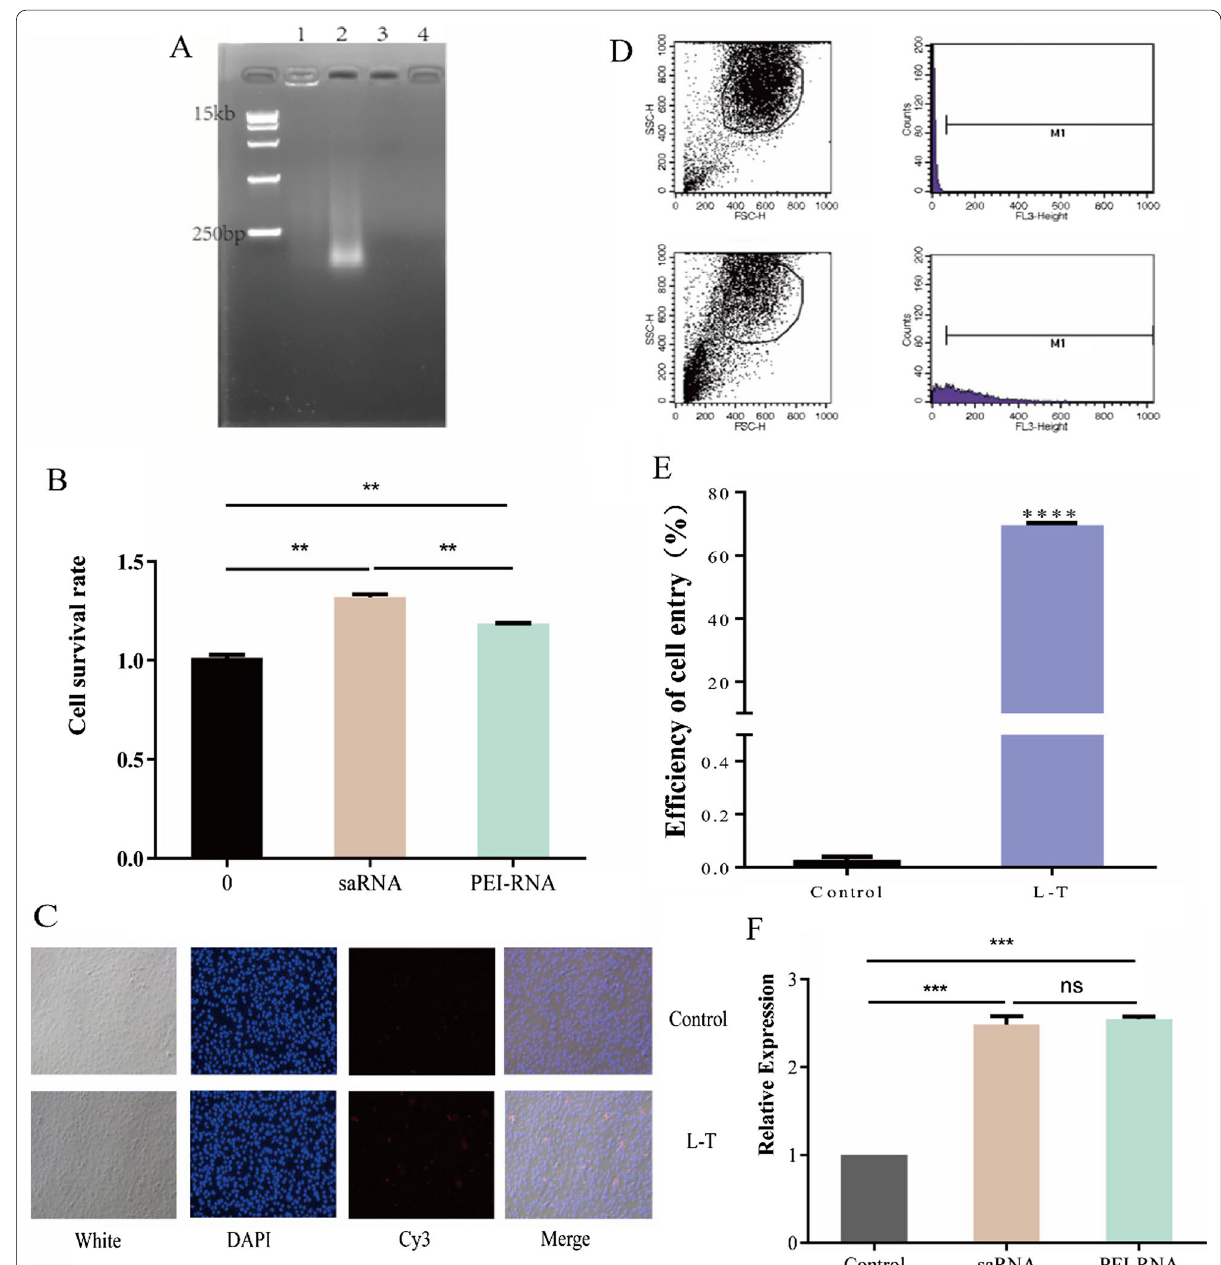
Fig. 3. A Gel image of the product after the complexation of NFs and PEI. Lane 1: PEI-NFs complexes; lane 2: NFs; lane 3: PEI; lane 4: negative control (The loading amount was the same for both (5 µL), and the amount of nucleic acid was 0.15 µg/µL). B Cellular viability of HUVECs exposed to saRNA and PEI-NFs for 24 h. “0” represents the control. C Fluorescence imaging of cells treated with PEI-NF complex for 24 h (magnification, 10 D Flow plots at 12 h after the NFs entered the cells. Results for the control group and experimental group are shown. E Efficiency of PEI-NF delivery into cells after 12 h (****P < 0.0001). F Relative VEGF expression in cells treated with saRNA or PEI-NFs complex for 72 h (**P < 0.01 vs